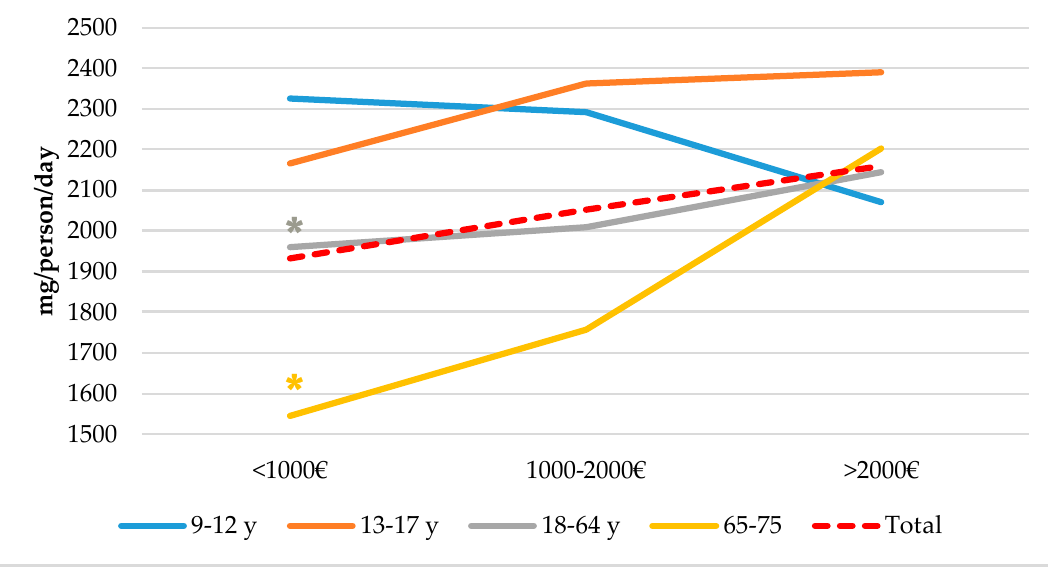
Figure 4. Sodium intakes by income level and age groups from the ANIBES study population. * p < 0.05 compared to >2000€ (Kruskal–Wallis test and the Dunn test to adjust for multiple comparison and adjust the p -value with Bonferroni correction).